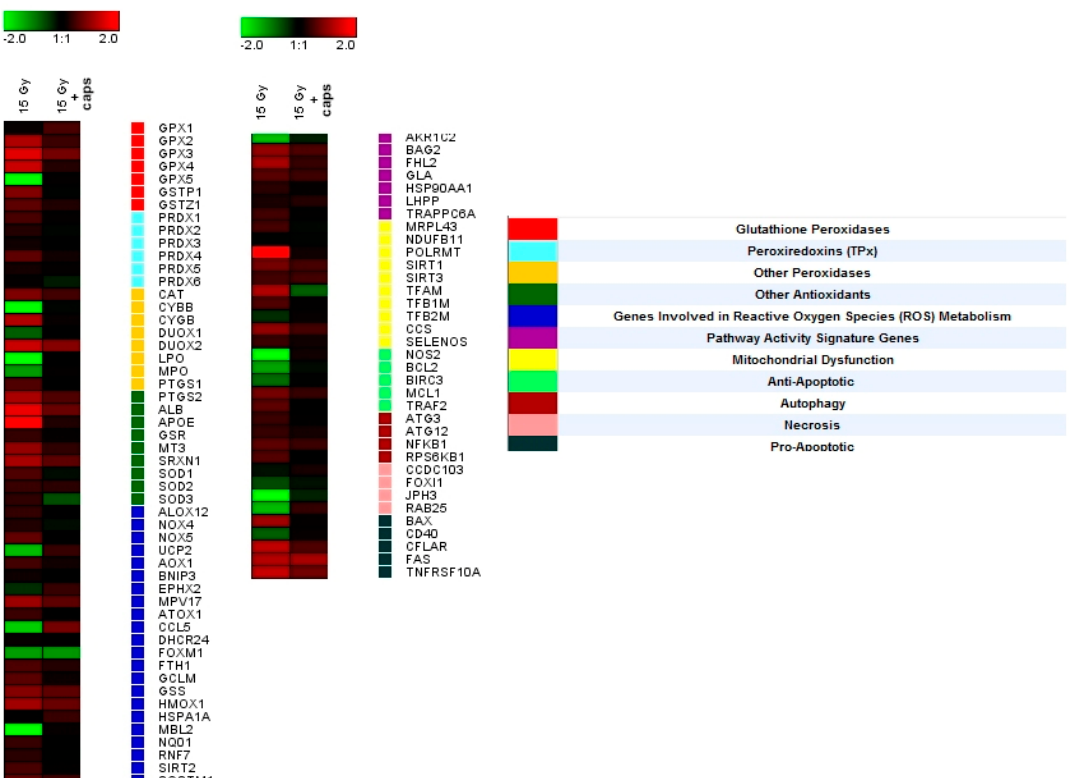
Figure 8. Heat map of gene expression in hMSC after 24 h of incubation with nanoceria-loaded polyelectrolyte microcapsules (10 capsules per cell). Nanoceria-loaded microcapsules were added to the adherent cells. The intensity scale of the standardised expression values ranges from –5 (green: low expression) to +5 (red: high expression), with a 1:1 intensity value (black) representing the control (cells not treated with microcapsules).